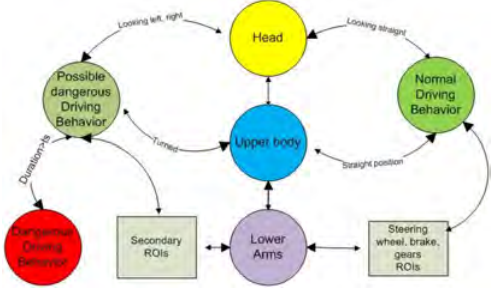
Figure 13. State based